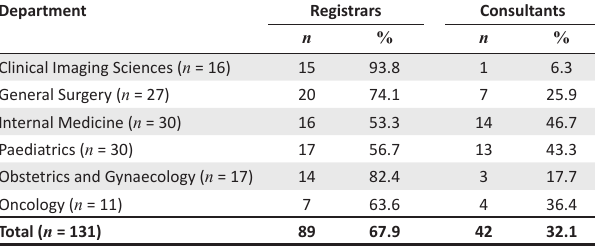
TABLE 3: Position of respondents per